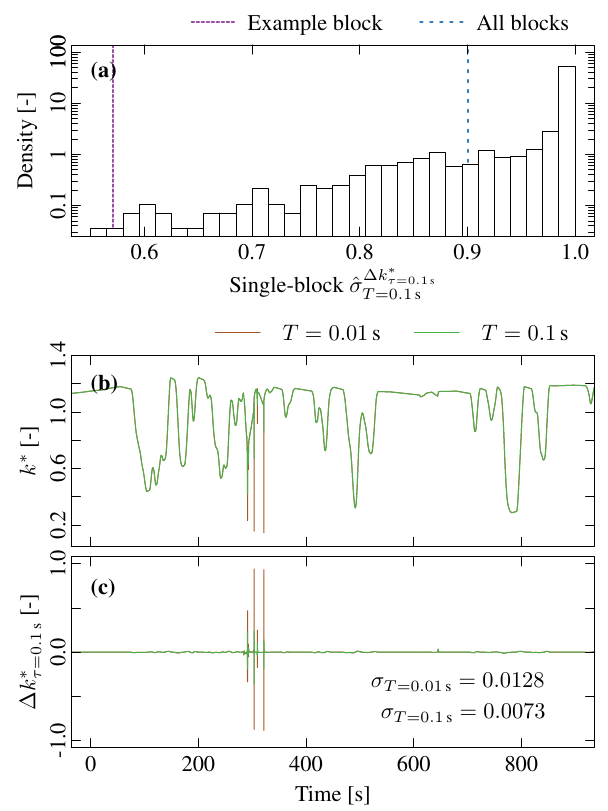
Figure 8. (a) The distribution of all Varennes-based single 900s- block values of normalized clear-sky index increment standard de- (cid:49)k ∗ τ T = 0 . 1 and τ = 0 . 1s, including an indication of viation ˆ σ T for the values corresponding to all blocks (as in Fig. 6) and to an exam- (cid:49)k ∗ τ = 0 . 57. Note the logarithmic ple block featuring a very low ˆ σ T scaling of the vertical axis. (b) Clear-sky index k ∗ time series of the 900s example block for T = 0 . 01 and T = 0 . 1s, measured in Varennes on 23 June 2016, starting at 07:41:40EDT. (c) The cor- responding clear-sky index increments (cid:49)k ∗ τ for an increment time step τ = 0 . 1s, quoting the values of the respective increment stan- dard